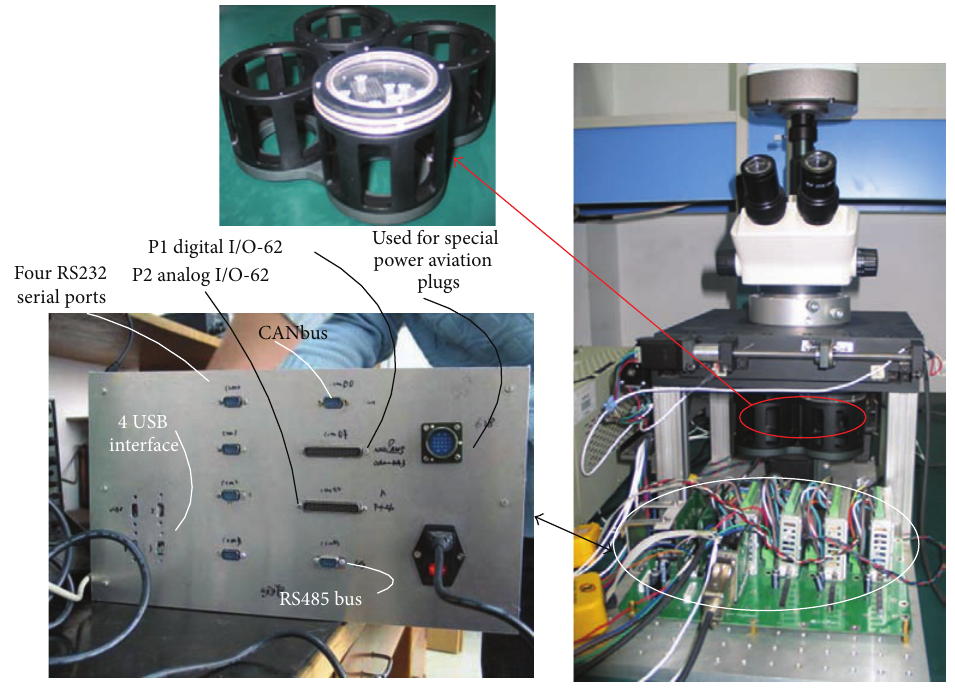
Figure 14: A photograph of cell culture and observation system platform.